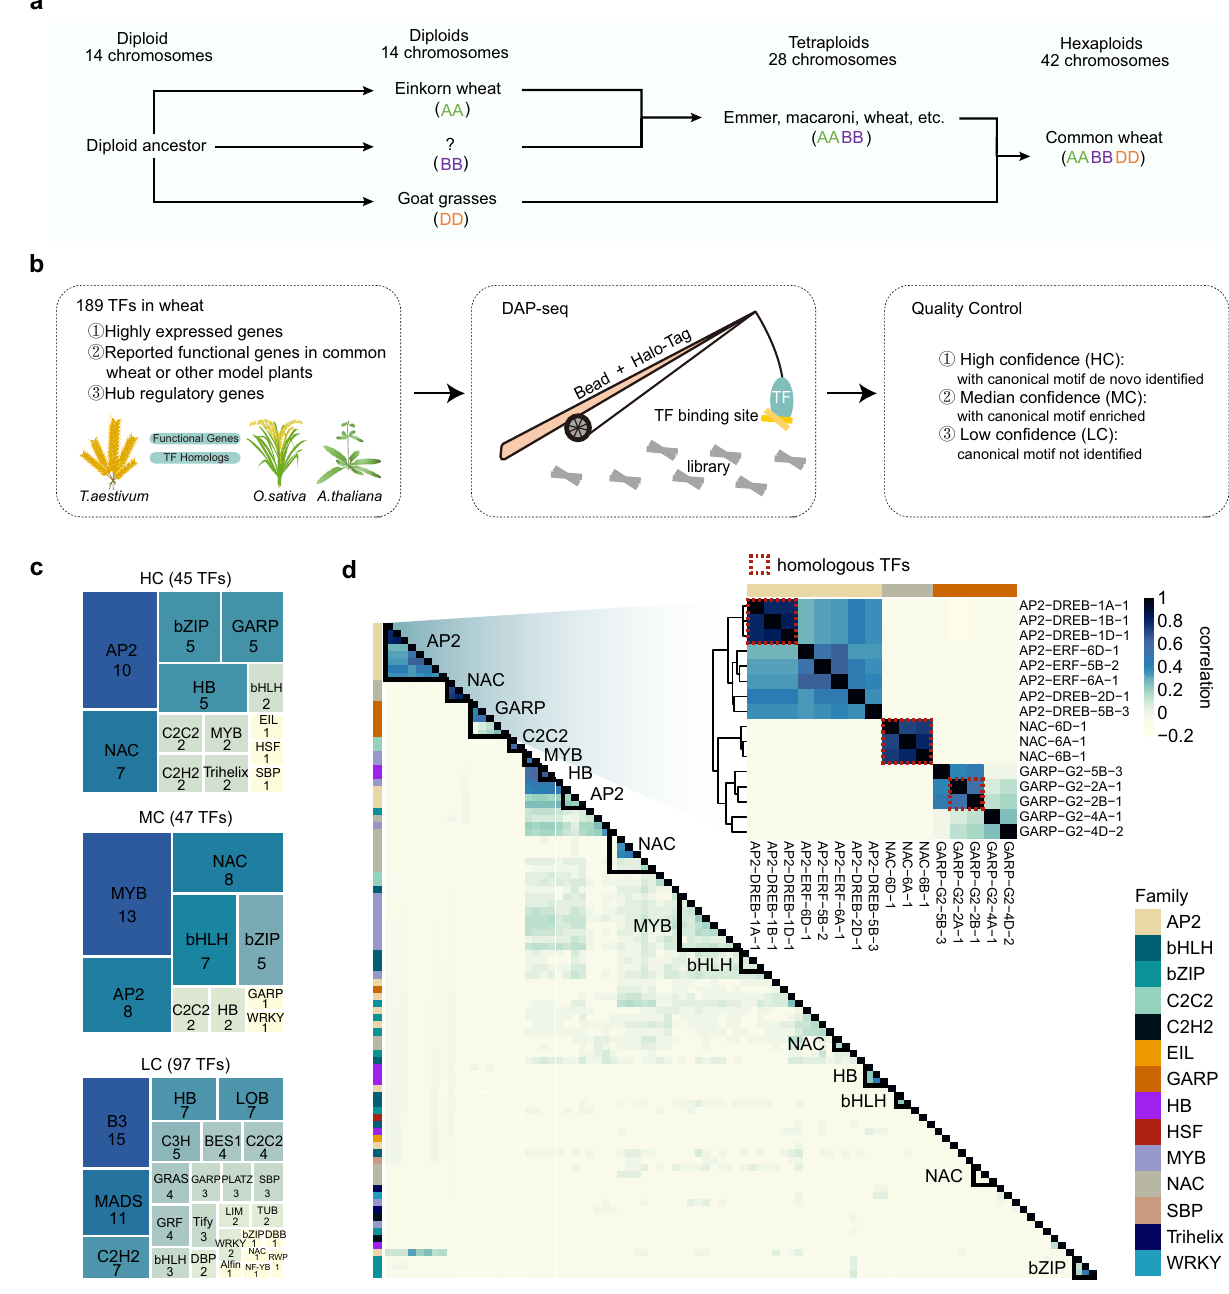
Fig. 1 | Genome-wide binding of wheat transcription factors. a Evolution of domesticated wheats (modi fi ed from ref. 8). b Schematic of the experimental design and fi ltering steps. c Tree map illustrating the fraction of transcription factor (TF) families de fi ned as high-con fi dence (HC; canonical motif de novo identi fi edfromtheTFpeaklist),median-con fi dence(MC;canonicalmotifenriched intheTFpeaklist),andlow-con fi dence(LC;canonicalmotifnotenrichedintheTF peak list) families. d Clustering of TF binding correlations according to the